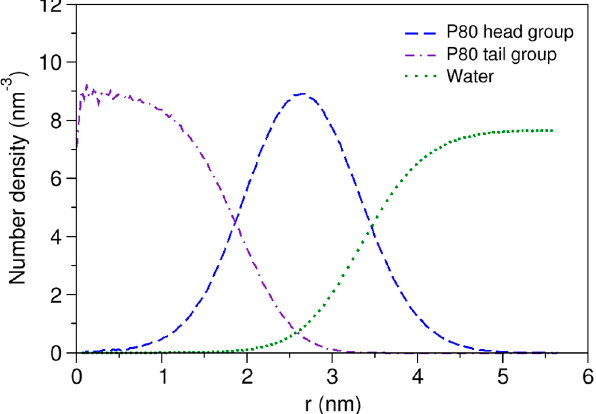
Figure 2. Density distribution of water and head and tail of P80 from micelle center of mass.